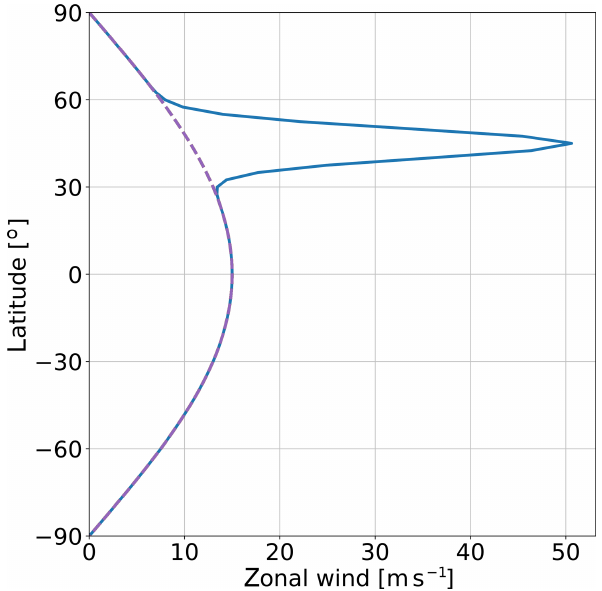
Figure 2. Latitudinal profiles of the background zonal wind u 0 (φ) for the strong narrow jet case (solid line) and for the pure solid-body rotation case (dashed